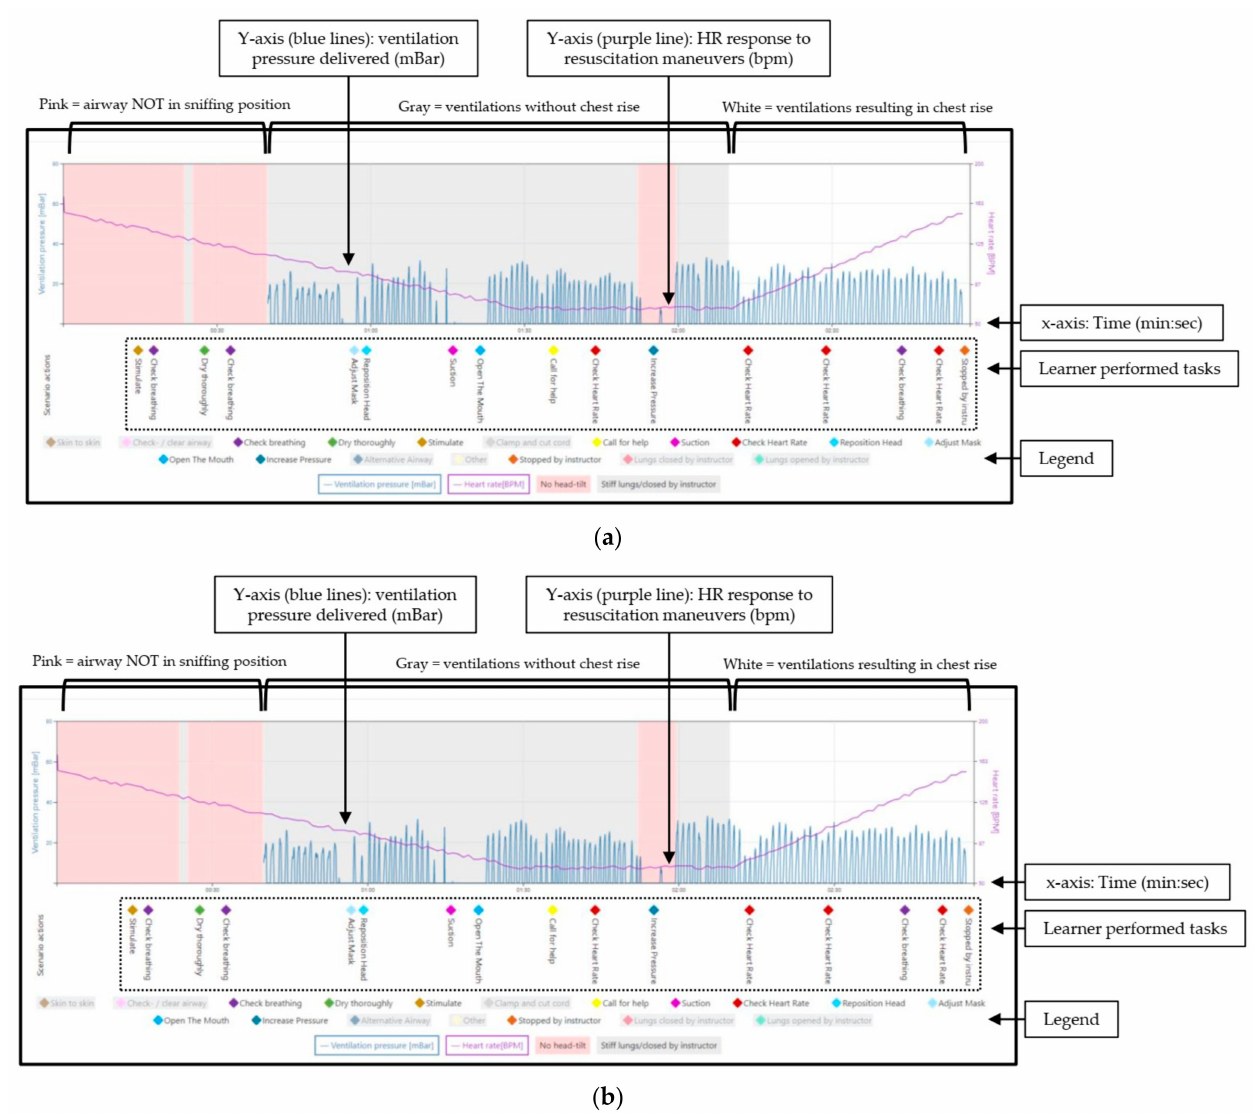
Figure 3. Neonatal resuscitation performance captured by the NeoNatalie Live manikin and tablet application. ( a ) Example of provider baseline performance before the facilitated debriefing with an instructor. ( b ) Example of provider performance after the facilitated debriefing with an instructor. Note that the HR (purple line) decreases steadily while there is no chest rise (gray background). Once effective ventilation is provided and chest rise occurs, the airway is opened (white background) and the HR